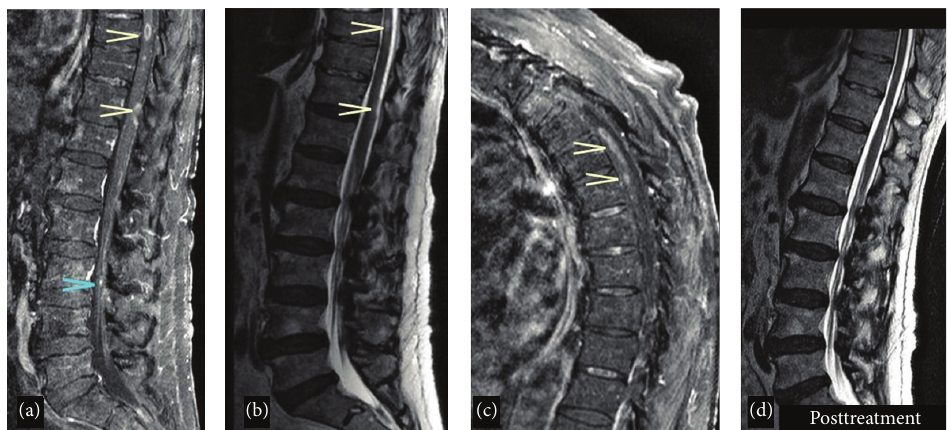
Figure 1: (a) Thoracic and lumbar sagittal MRI and T1 postgadolinium contrast image demonstrating areas of intramedullary enhancement at the levels of T9 and T11, as well as cauda equina enhancement (blue arrow). (b) Sagittal T2 image showing corresponding areas of T2 hyperintensity at the same levels. (c) Sagittal T1 postgadolinium contrast demonstrates enhancement at multiple thoracic levels. (d) Sagittal T2 image after 6 weeks of antiviral treatment demonstrating near resolution of these changes (postcontrast image, not shown, demonstrates resolution of